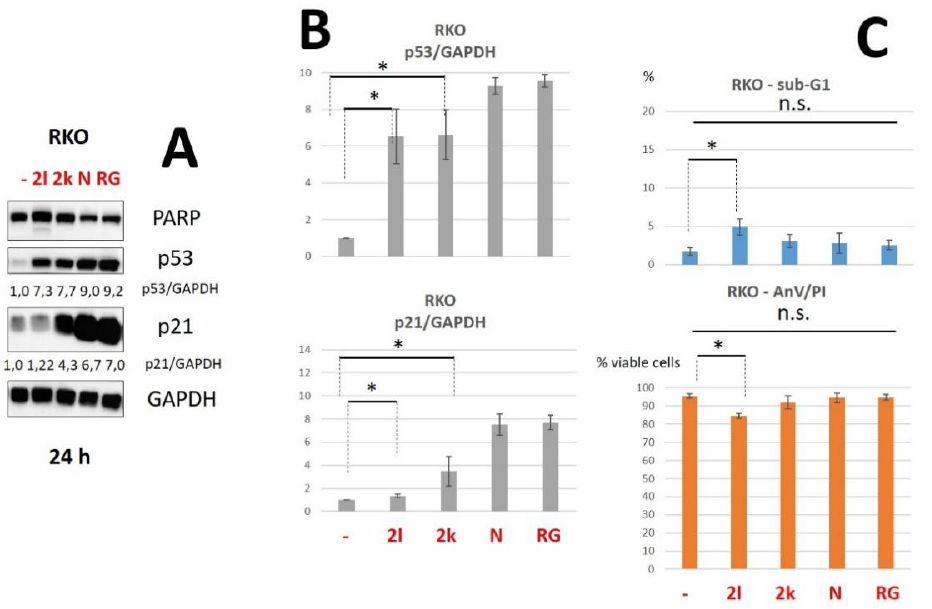
cells — cells negative for both Annexin V-FITC and propidium iodide (PI). Data from n = 3 biological replicates are shown as mean ± s.d., * p < 0.05, n.s. — not significant. PARP — poly (ADP-ribose)-pol-